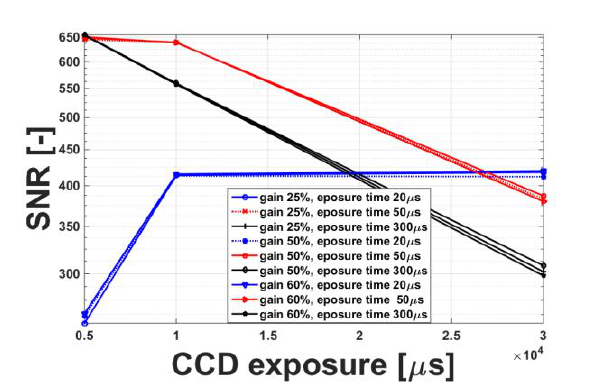
Fig. 18. Signal-to-noise ratio depending on CCD exposure time for different setup. Hamamatsu C10880-03